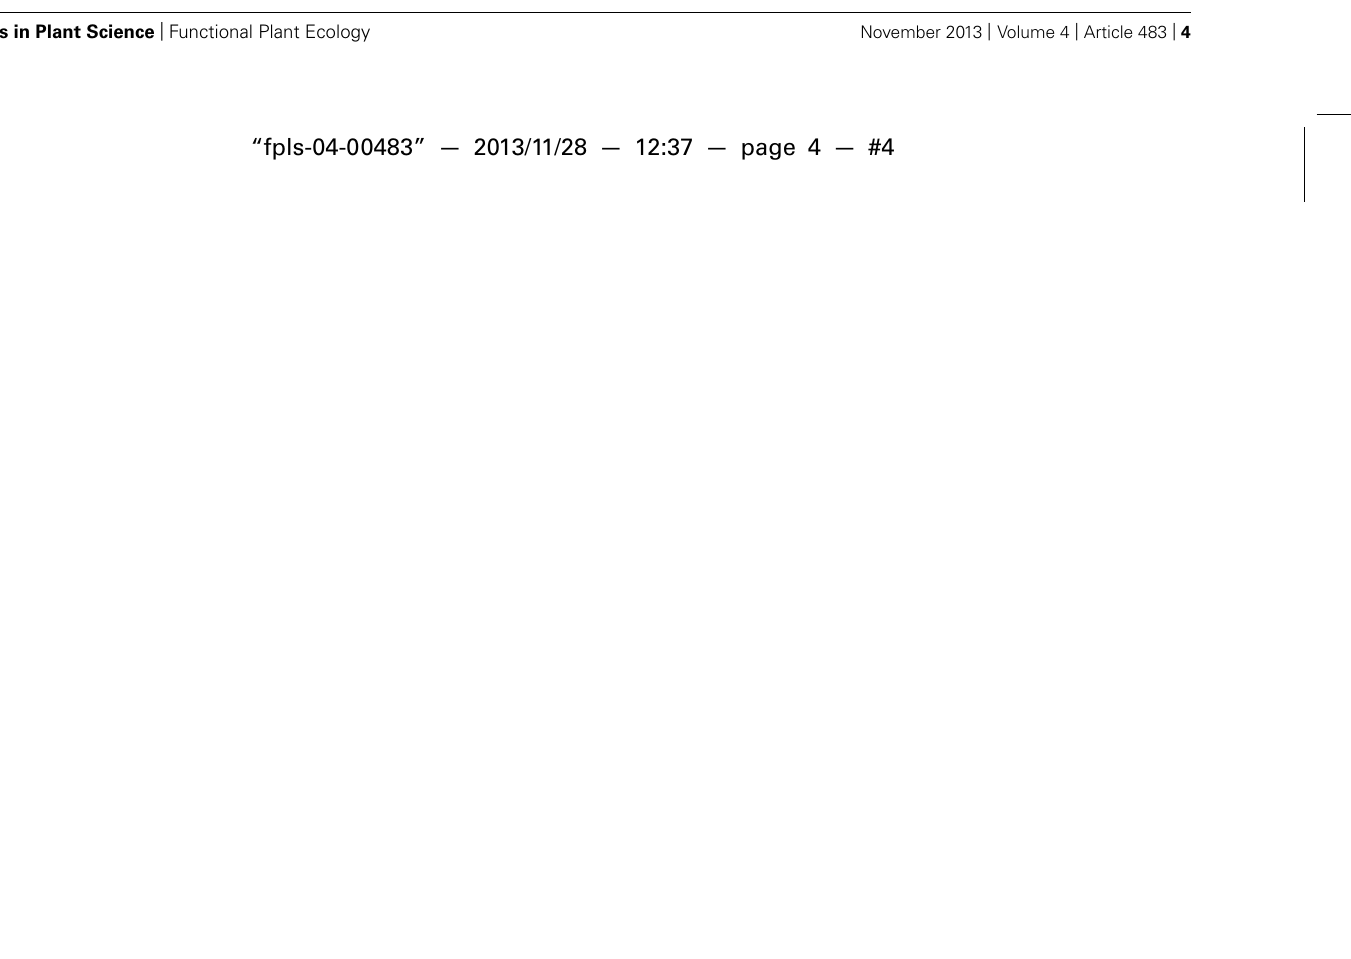
the sixth leaf during 8 days following its emergence.The difference was associated to a color, with closeness to green indicating growth preferentially in the daytime and closeness to red indicating growth preferentially in the nighttime. Note that moderate soil water stress increases nighttime growth relative to daytime growth in all